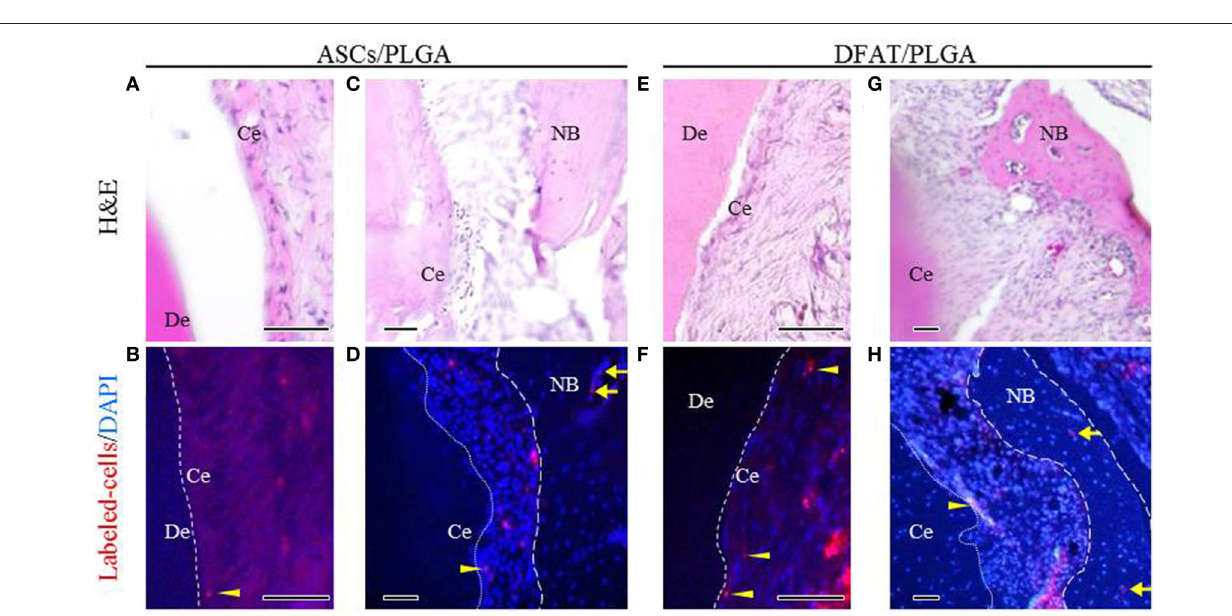
FIGURE 10 | Localization of fluorescent-labeled ASCs and DFAT cells analyzed via fluorescence microscopy 5 weeks after transplantation. (A,C,E,G) Highly magnified fluorescence images of the fenestration defect in the distal root of the first molar. (H&E staining; scale bar: 50 µ m). (B,D,F,H) The dotted line indicates newly formed periodontal ligament tissue between cementum and bone. Fluorescent-labeled ASCs and DFAT cells were observed in periodontal ligament beside the bone (arrows) and cementum (arrowheads). (Blue color: DAPI; Scale bar: 50 µ m.). NB, newly formed bone; Ce, newly formed cementum; De, root